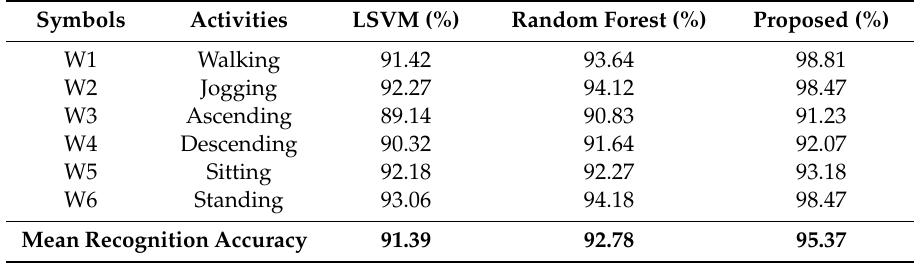
Table 4. WISDM dataset results over the proposed classifier and other well-known statistical classifiers. Symbols